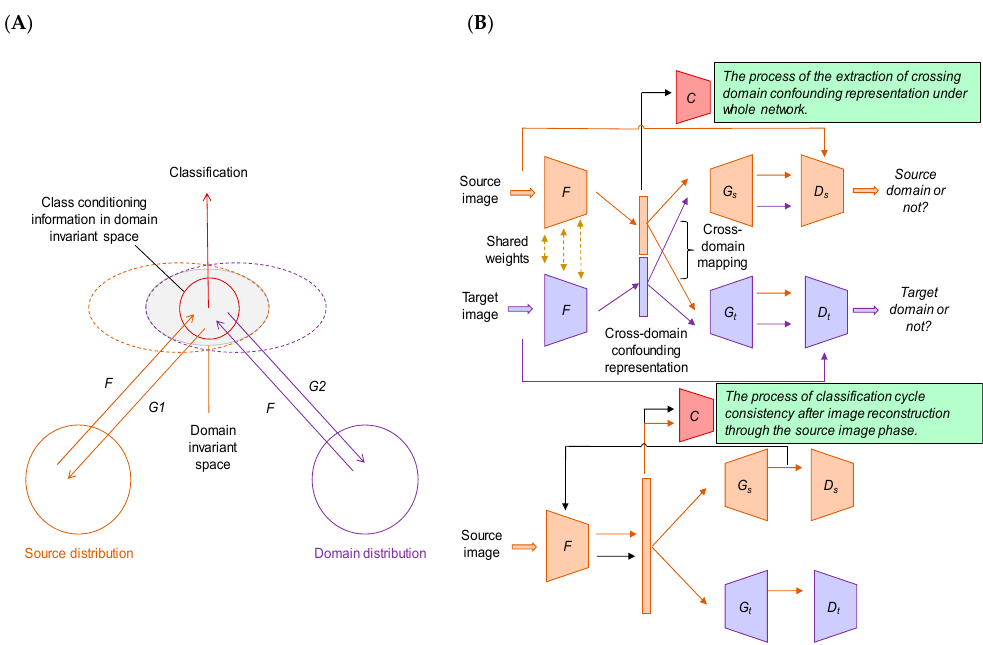
Figure 4. Illustration of the proposed network in Reference 188 (Qin et al., 2020); this is a modified figure from the reference. ( A ) Illustration of the proposed method: a cross-domain confounding representation is generated by constraining the cross-domain mapping reconstruction. ( B ) Domain confounding representation through cross-domain mapping and classification cycle consistency.